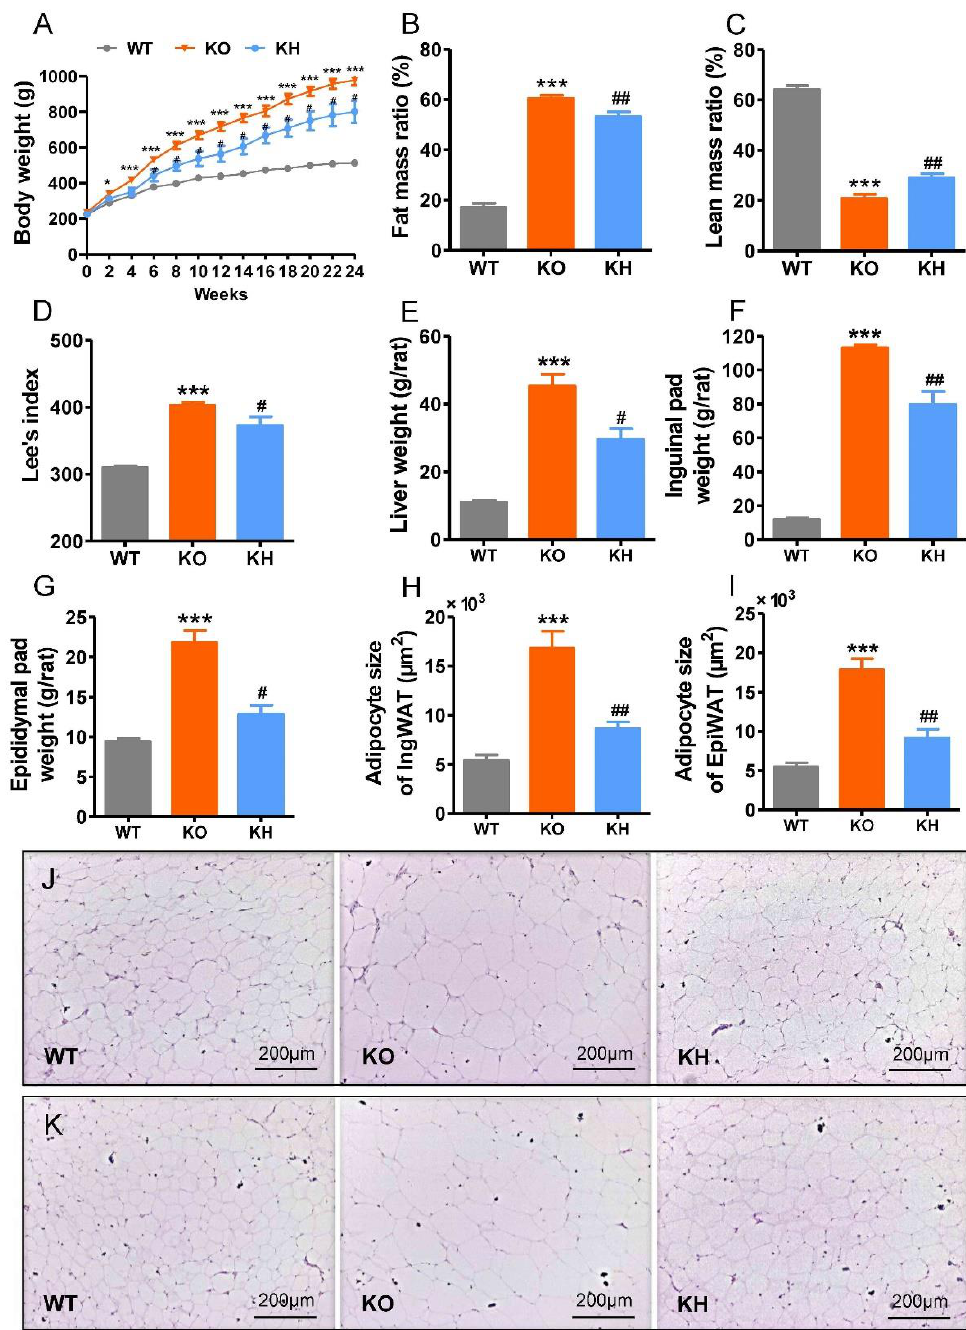
Figure 1. HTE attenuated phenotypes of obesity in Lepr −/− rats. HTE, Huangshan Maofeng green tea extracts; WT, wild type littermates; KO, leptin receptor knockout rats; KH, leptin receptor knockout rats with HTE administration. ( A ) Body weight; ( B ) fat mass ratio; ( C ) lean mass ratio; ( D ) Lee’s index; ( E ) liver weight; ( F ) inguinal fat weight; ( G ) epididymal fat weight; ( H ) adipocyte size of inguinal fat; ( I ) adipocyte size of epididymal fat; ( J , K ) Hematoxylin–eosin staining of the inguinal fat and epididymal fat (100 × magnification). * p < 0.05, *** p < 0.001, compared to WT group; # p < 0.05, ## p < 0.01 versus KO group ( n = 4 –6, means ± SEM).